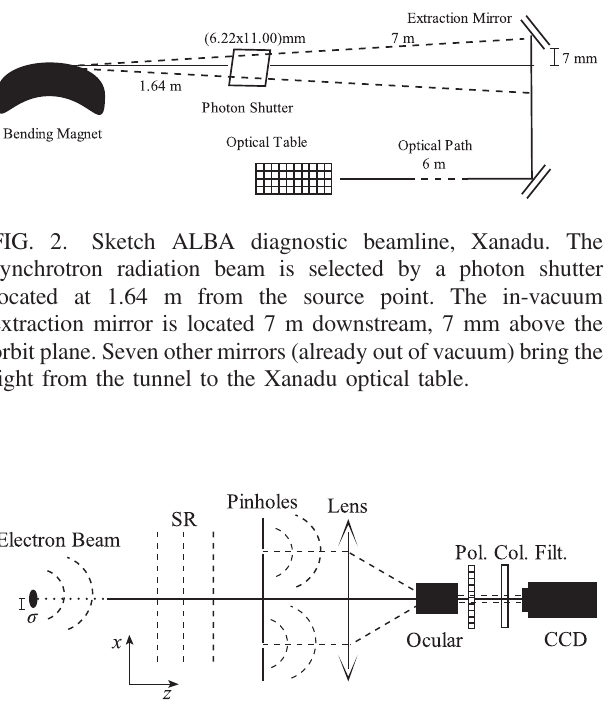
FIG. 3. Sketch of the SRI experimental setup: the synchrotron radiation (SR) produced by the beam passes through the double pinhole system and is imaged through a lens and an objective ocular to the CCD. The radiation polarization and the wavelength are selected through a polarizer (Pol.) and a color filter (Col. Filt.).